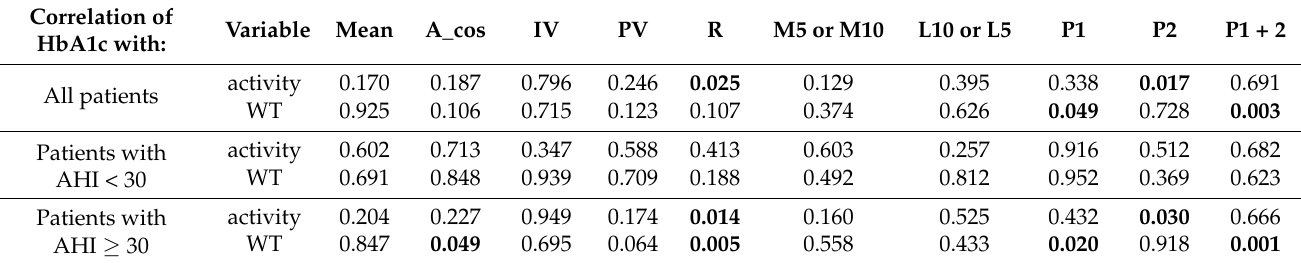
Table 2. p Values obtained from Pearson correlation between HbA1c and circadian variables obtained with activity and wrist temperature (WT) data. Correlations were carried out considering BMI as a confounding variable. Significant differences are indicated in bold.